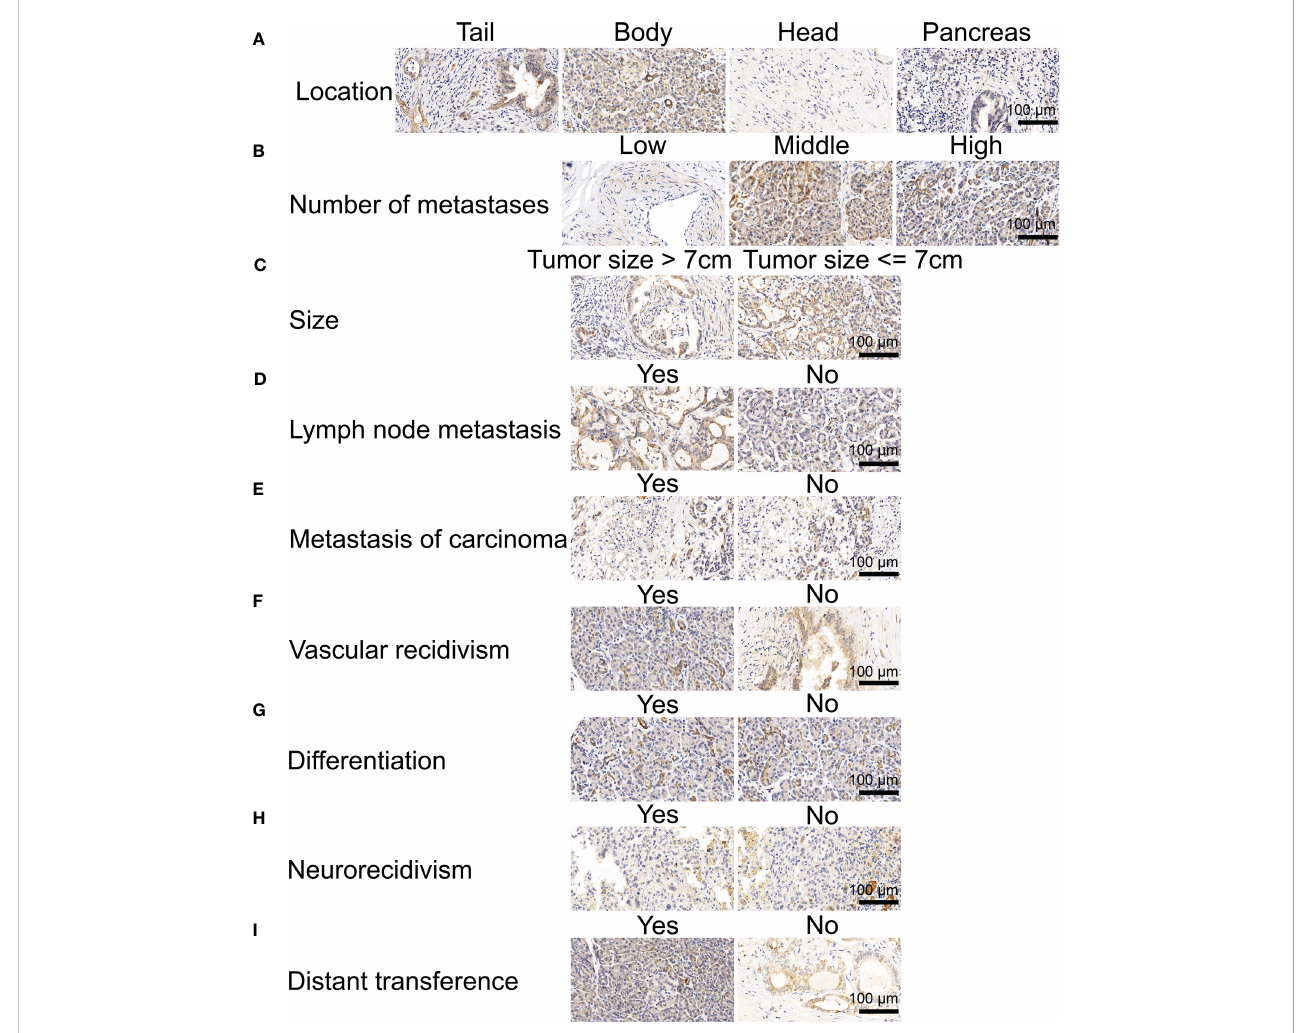
FIGURE 2 Immunohistochemical analysis of NOX4 in pancreatic cancer. (A) Immunohistochemical analysis of patients in different location. (B) Immunohistochemical analysis of patients with different numbe of metastases. (C) Immunohistochemical analysis of patients with different tumor size. (D) Immunohistochemical analysis of patients with and without lymph node metastasis. (E) Immunohistochemical analysis of patients with and without metastasis of carcinoma. (F) Immunohistochemical analysis of patients with and without vascular recidivism. (G) Immunohistochemical analysis of patients with and without differentiation. (H) Immunohistochemical analysis of patients with and without neurorecidivism. (I) Immunohistochemical analysis of patients with and without distant